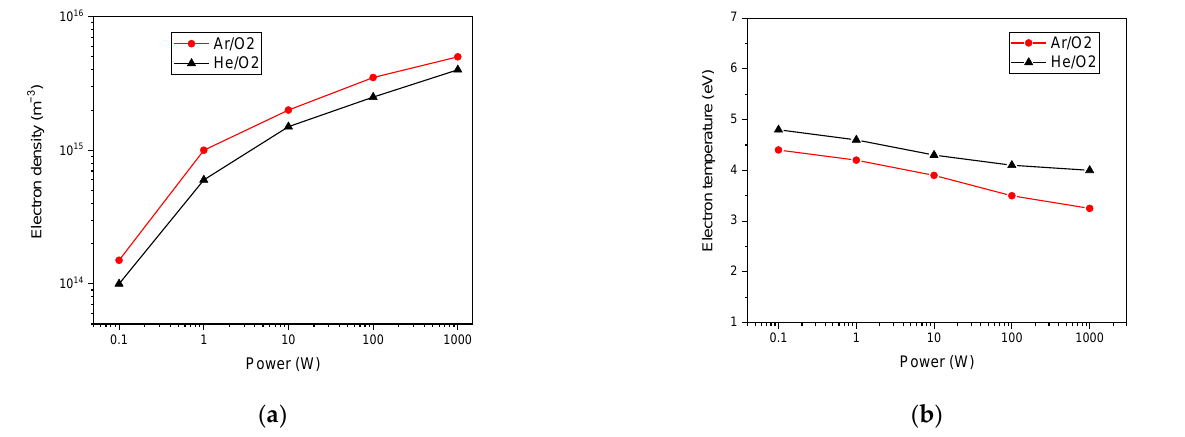
Figure 12. Density and temperature of electrons in Ar/O 2 mixture for different O 2 percentages at 0.3 Torr total gas pressure and RF voltage (150 V, 13.56 MHz).